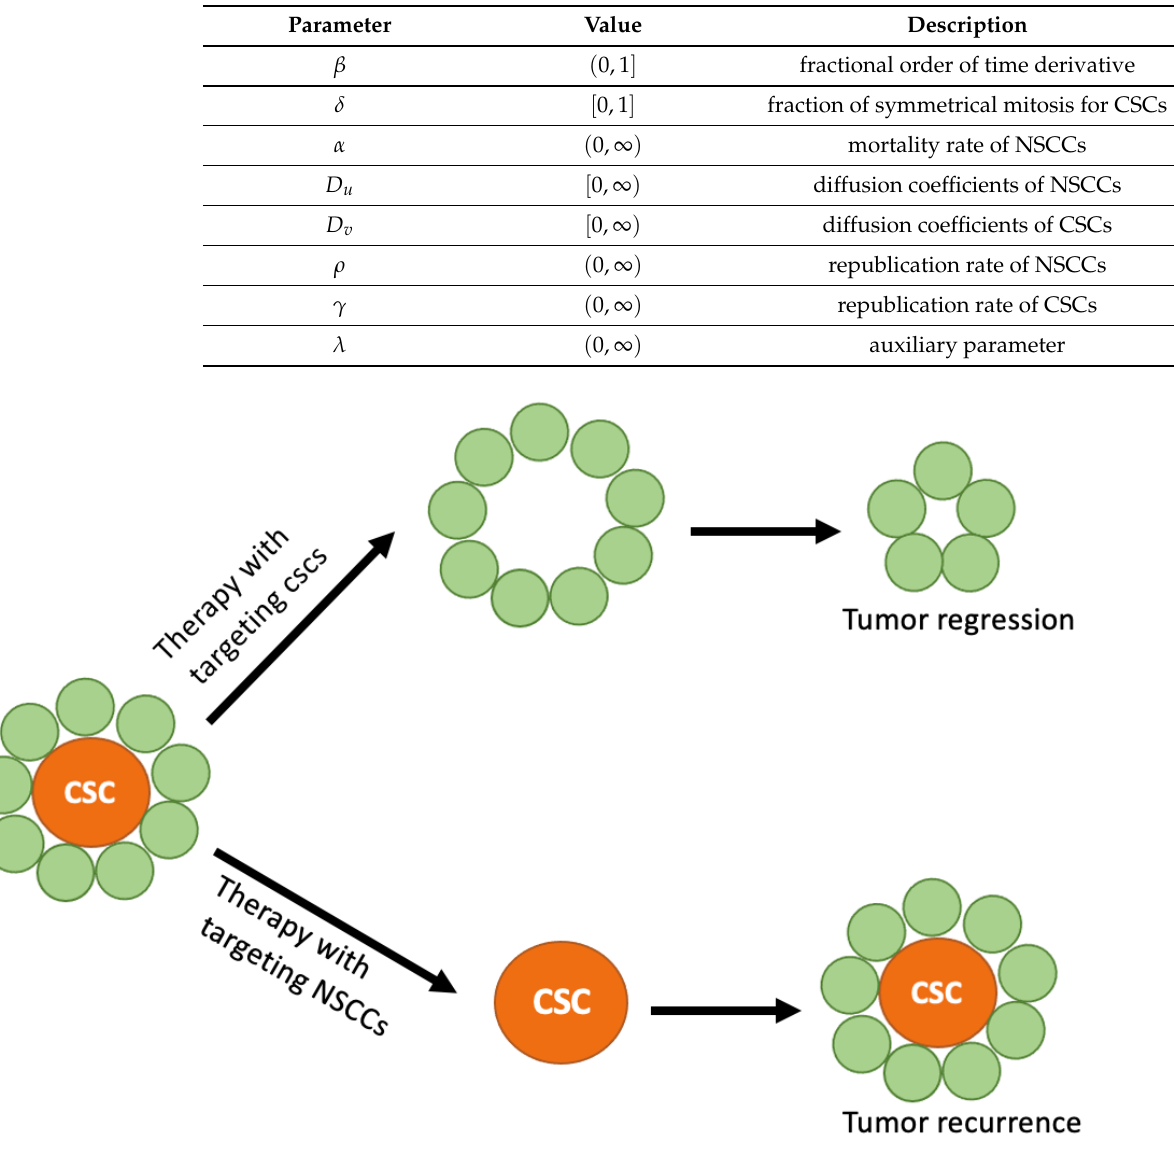
Figure 1. The distinction between CSC-targeted therapy and NSCC-targeted (traditional)